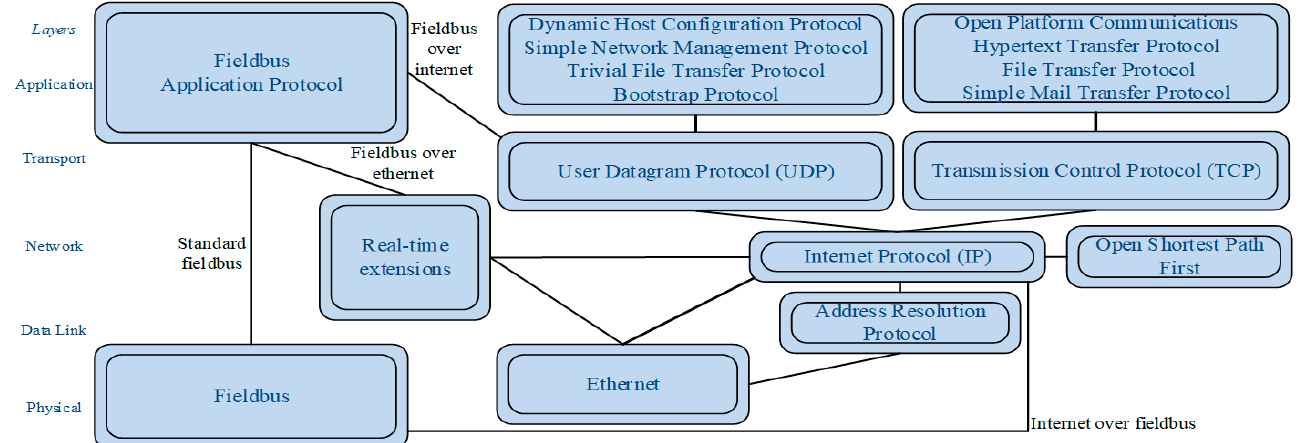
Figure 1. Structure of Ethernet and fieldbus in relation to protocol stack based on TCP/IP model.